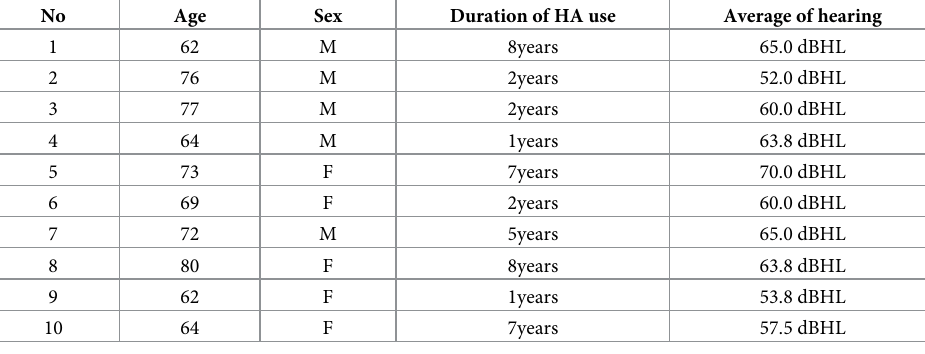
Table 1. The background of the hearing aid users. No Age Sex Duration of HA use Average of